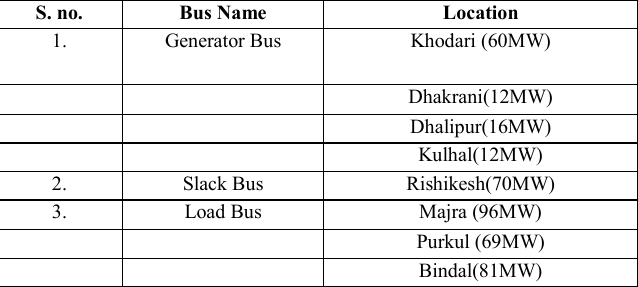
Table 6. BUS DATA OF DEHRADUN SYSTEM IN 2015 S. no.